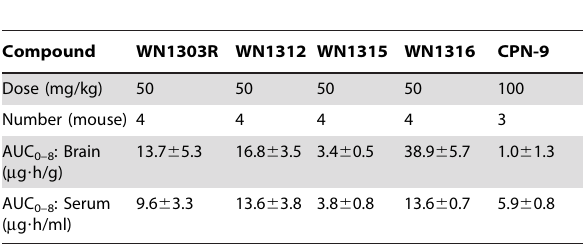
Table 1. Brain and blood concentration of four WN- compounds and